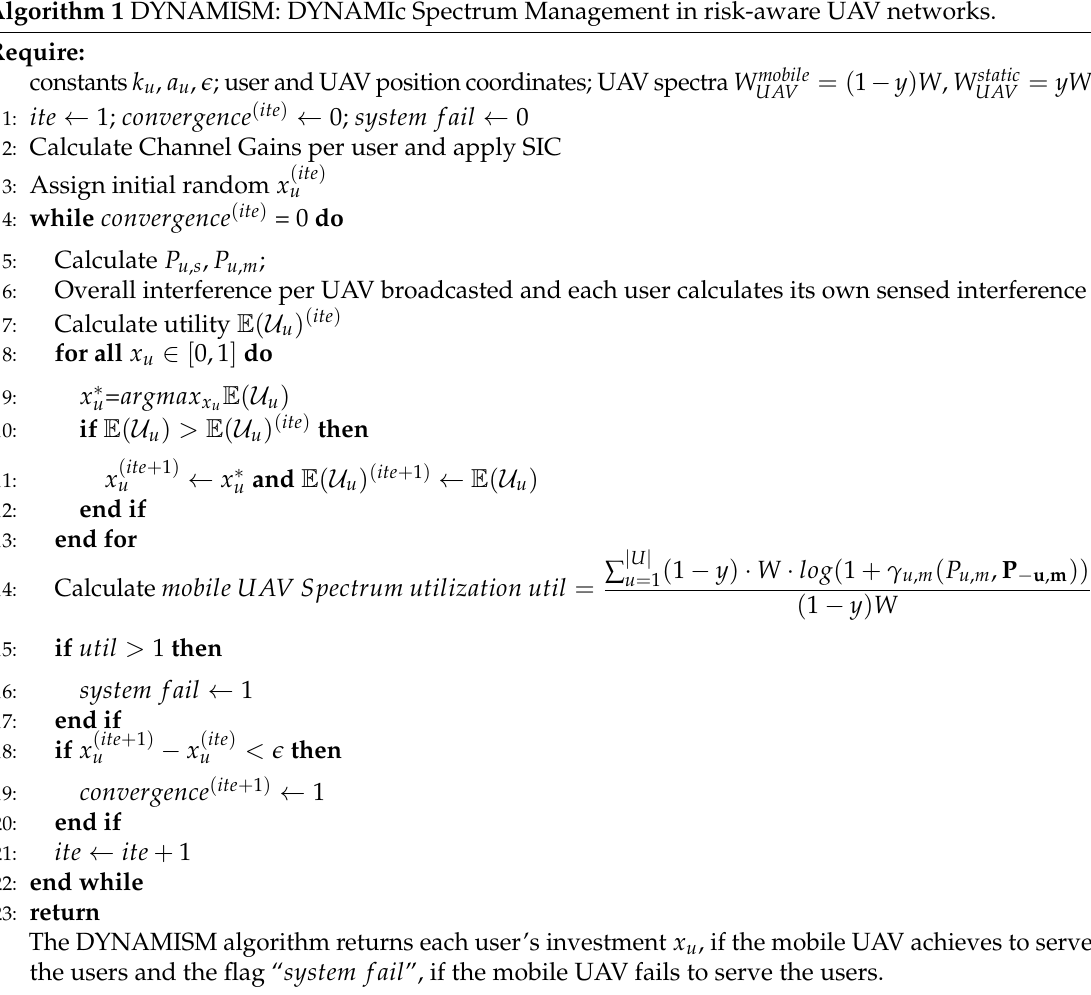
Algorithm 1 DYNAMISM: DYNAMIc Spectrum Management in risk-aware UAV